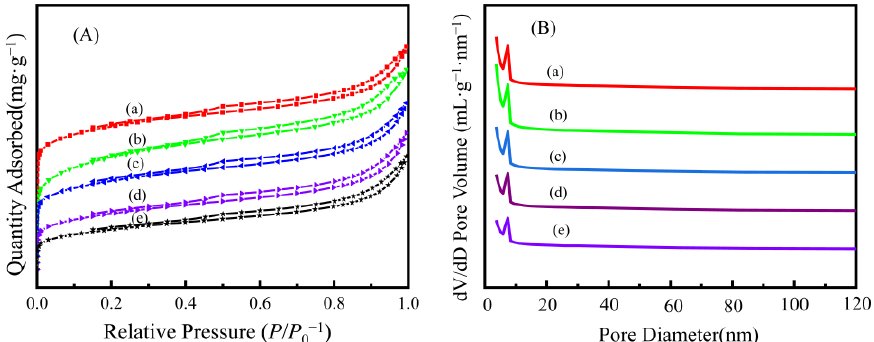
Figure 4. Magnetization curves of the AAM-MSMPM ( a ) and Cd(II)/AAM-MSMPM ( b ), and the